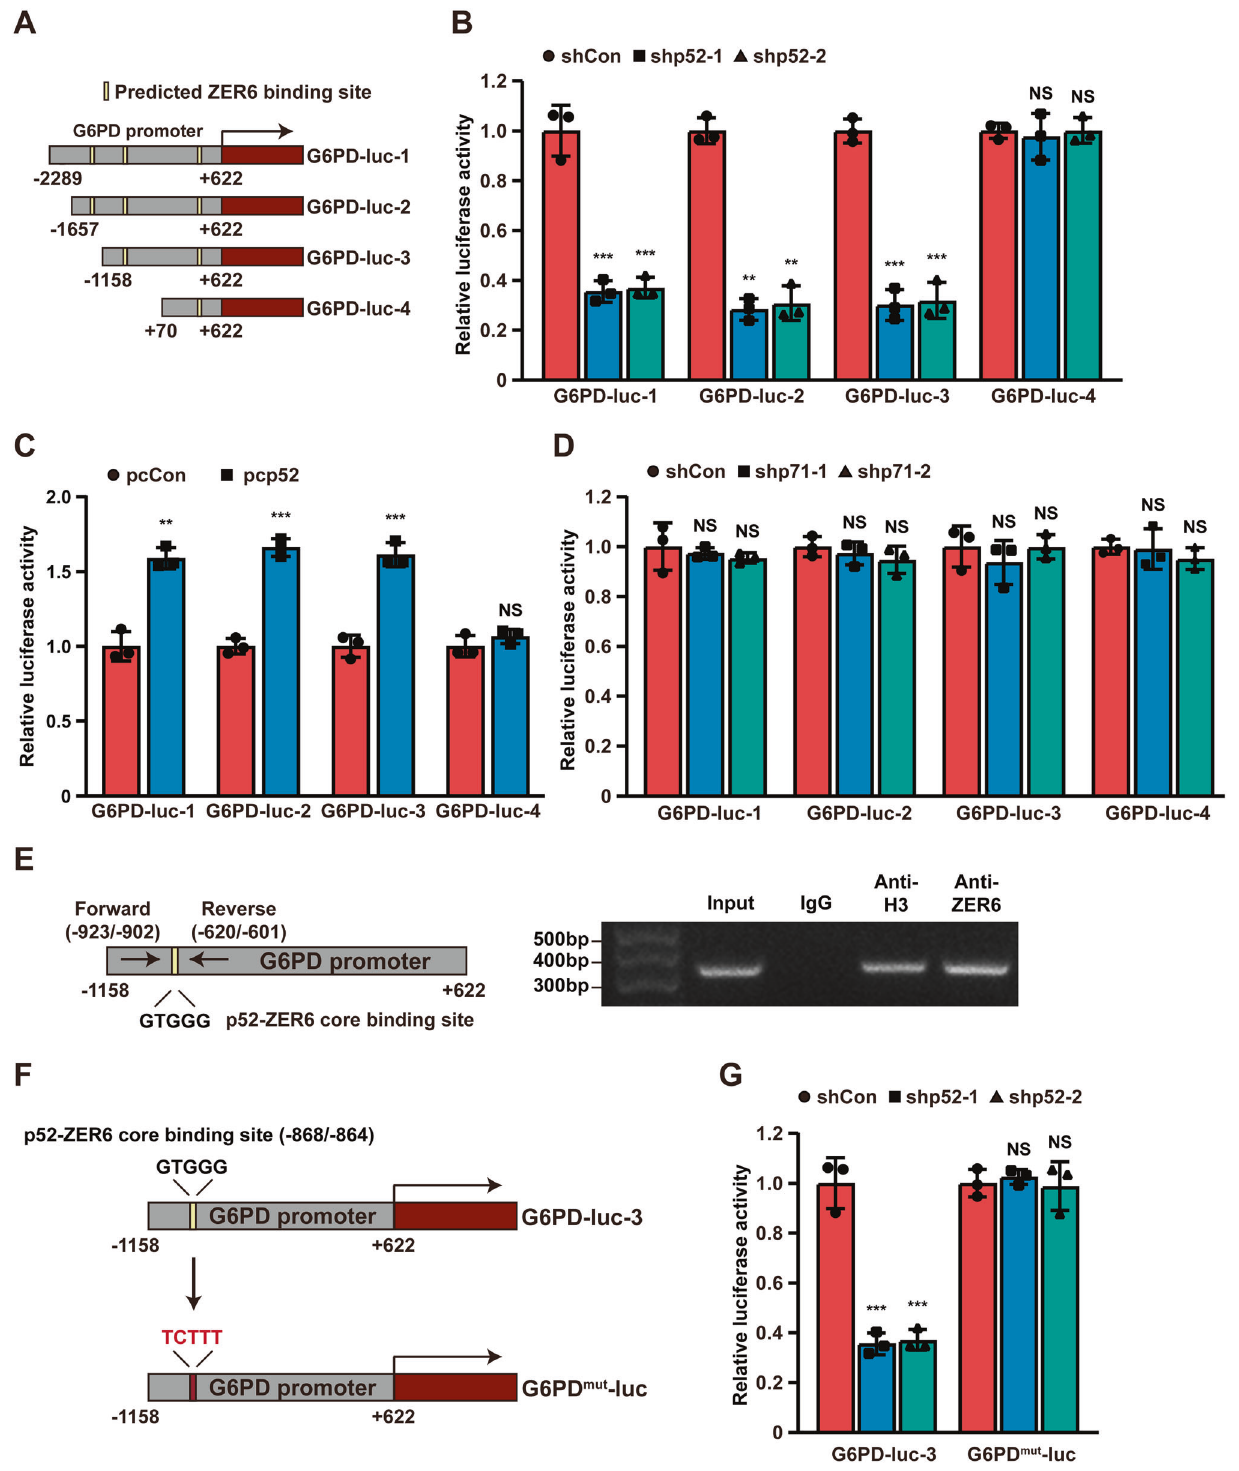
Fig. 5 p52-ZER6 directly promotes G6PD transcriptional activity by binding to its promoter. A Schematic diagram of the luciferase reporter vectors carrying various G6PD promoter regions. B , C Relative luciferase activities of G6PD-luc-1 to G6PD-luc-4 in p52-ZER6 -silenced ( B ) and p52-ZER6 -overexpressed ( C ) HCT116 cells. D Relative luciferase activities of G6PD-luc-1 to G6PD-luc-4 in p71-ZER6 -silenced HCT116 cells. E Binding of p52-ZER6 to the promoter region of G6PD , as examined using ChIP assay with anti-ZER6 antibody and followed by PCR. The predicted p52-ZER6 binding site on the promoter region of G6PD and the location of primer set used for PCR are shown. Anti-histone H3 antibody was used as a positive control. F , G Relative luciferase activities of G6PD mut -luc in p52-ZER6 -silenced HCT116 cells. Schematic diagram ( F ) and luciferase activities ( G ) are shown. Mutated base pairs are indicated in red. Cells transfected with shCon or pcCon were used as controls. Luciferase activities are shown as relative to control. Quanti fi cation data are expressed as mean ± SD ( n = 3). shp52: shRNA expression vector targeting p52-ZER6 ; shp71: shRNA expression vector targeting p71-ZER6 ; pcCon: pcEF9-Puro; pcp52: p52-ZER6 overexpression vector; ** P < 0.01; *** P < 0.001; NS not signi fi